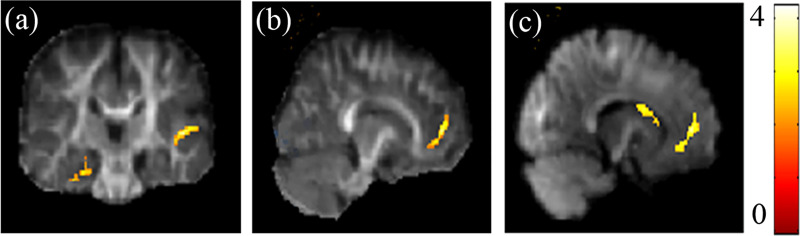
Group effect on DSI indices.Significantly (a) reduced GFA in the right superior temporal gyrus and (b) the left medial frontal gyrus, (c) reduced NQA in the left medial frontal gyrus and the left caudate body were found in RD compared with controls. The color bar presents t-score (corrected p < 0.05).